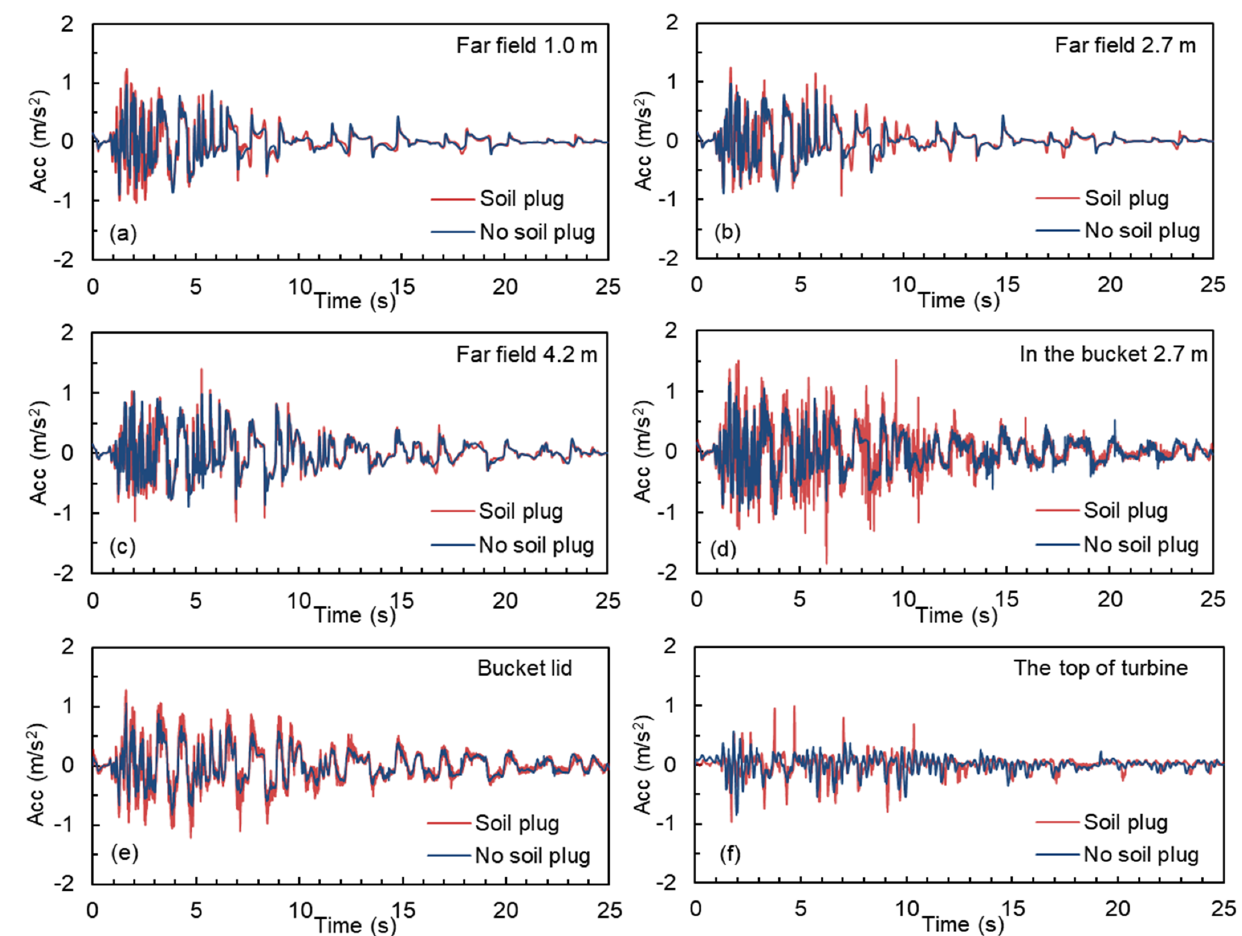
Figure 5. Acceleration time histories for seabed soil and turbine (WBF) with and without soil plug in 50% relative density inclined liquefiable seabeds: ( a ) far field seabed soil at 1.0 m depth; ( b ) far field seabed soil at 2.7 m depth; ( c ) far field seabed soil at 4.2 m depth; ( d ) seabed soil in the bucket at 2.7 m depth; ( e ) bucket lid; ( f ) top of OWT turbine.